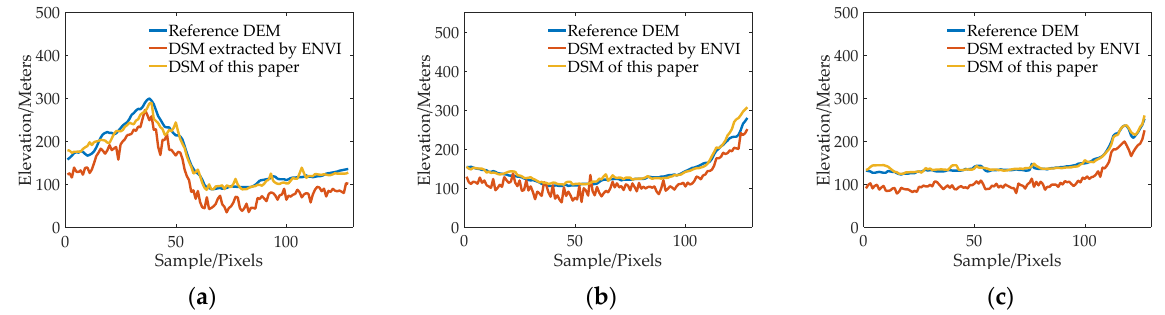
Figure 11. The elevation profiles comparison of three valley regions: ( a ) Region 1; ( b ) Region 2; ( c ) and Region 3.